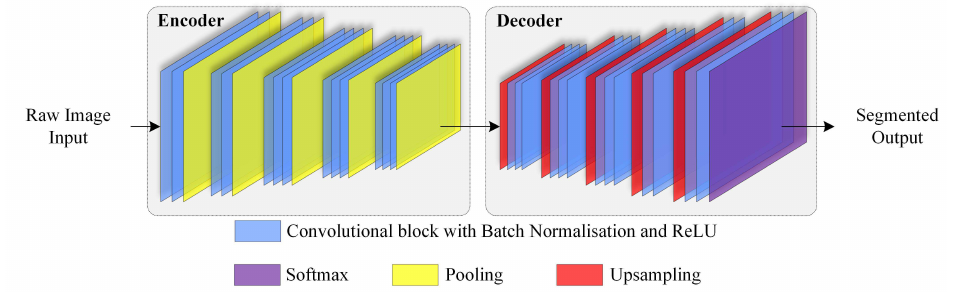
SegNet received inspiration from U-Net and improved using a symmetrical en- coder–decoder structure as a pixel-wise end-to-end network where the input image would go through two stages of downsampling and